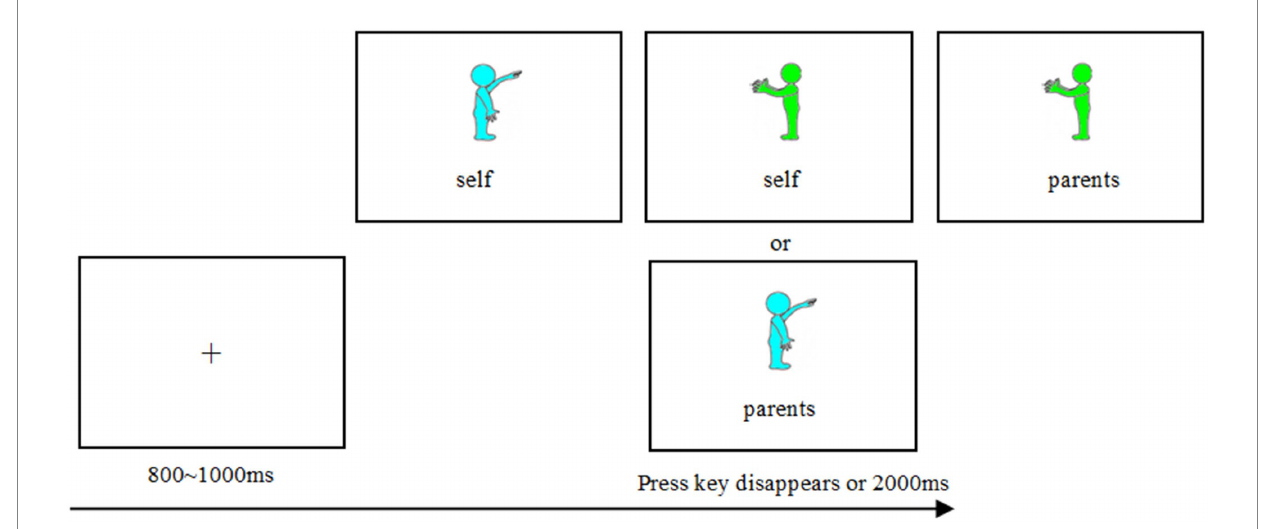
FIGURE 1 Schematic diagram of the color-identity connection task experiment process.